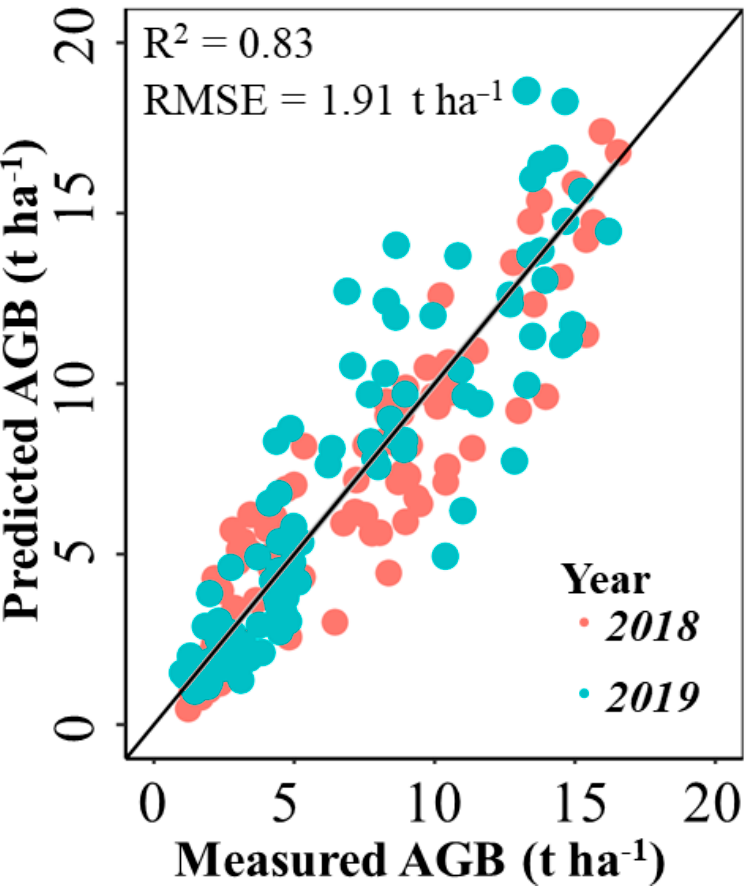
Figure 5. Comparison of measured and predicted AGB with CBA-wheat